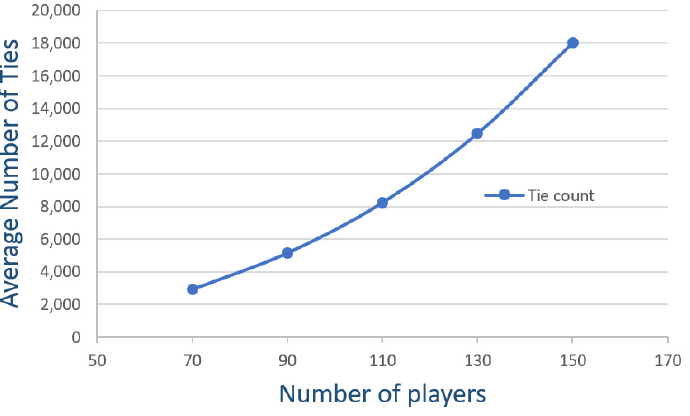
Figure 7. Average number ties in RPS scheme 200 nodes.